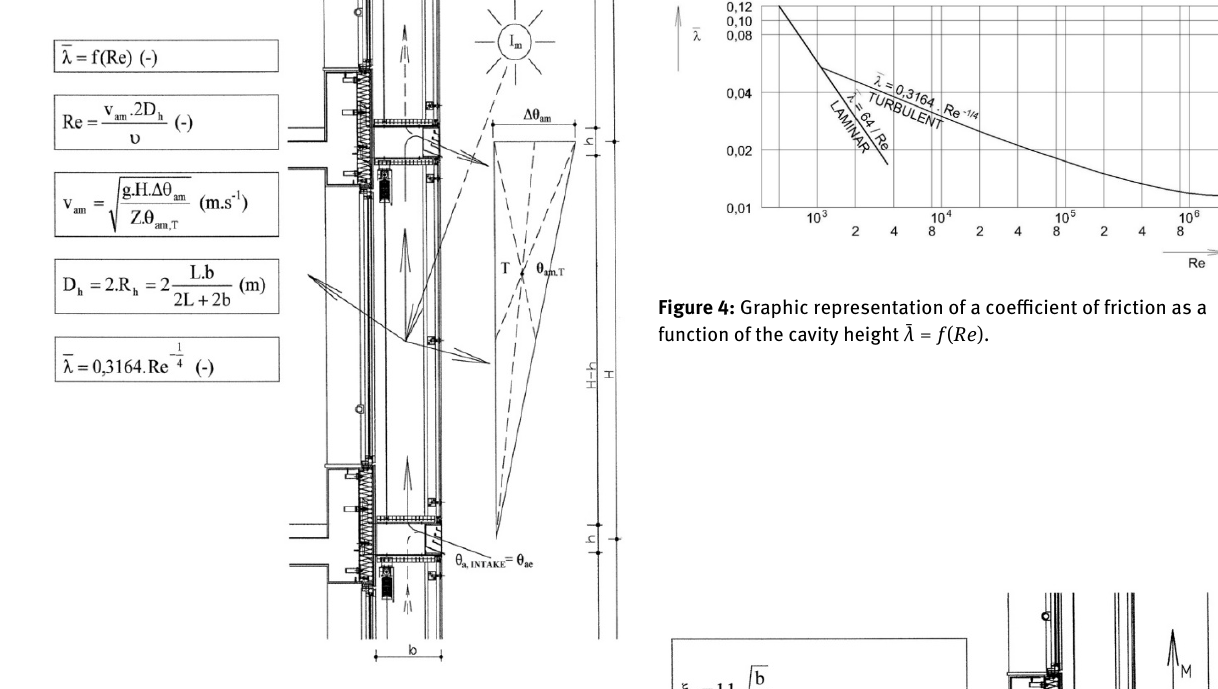
Figure 3: Coeflcient of friction resistance along the height of the trajectory of the convective air flow (Re - Reynolds criterial num- ber (-),v am – air flow velocity in the cavity (m/s), ν – coeflcient of kinematic viscosity of air (m 2 /s), g – gravitational acceleration co- eflcient (9,81 m/s 2 ), ∆Θ am – temperature increase in the cavity (K), Θ am,T – temperature in the centre mass point of the triangle surface A = f(H, ∆Θ am ) ( ∘ C)).